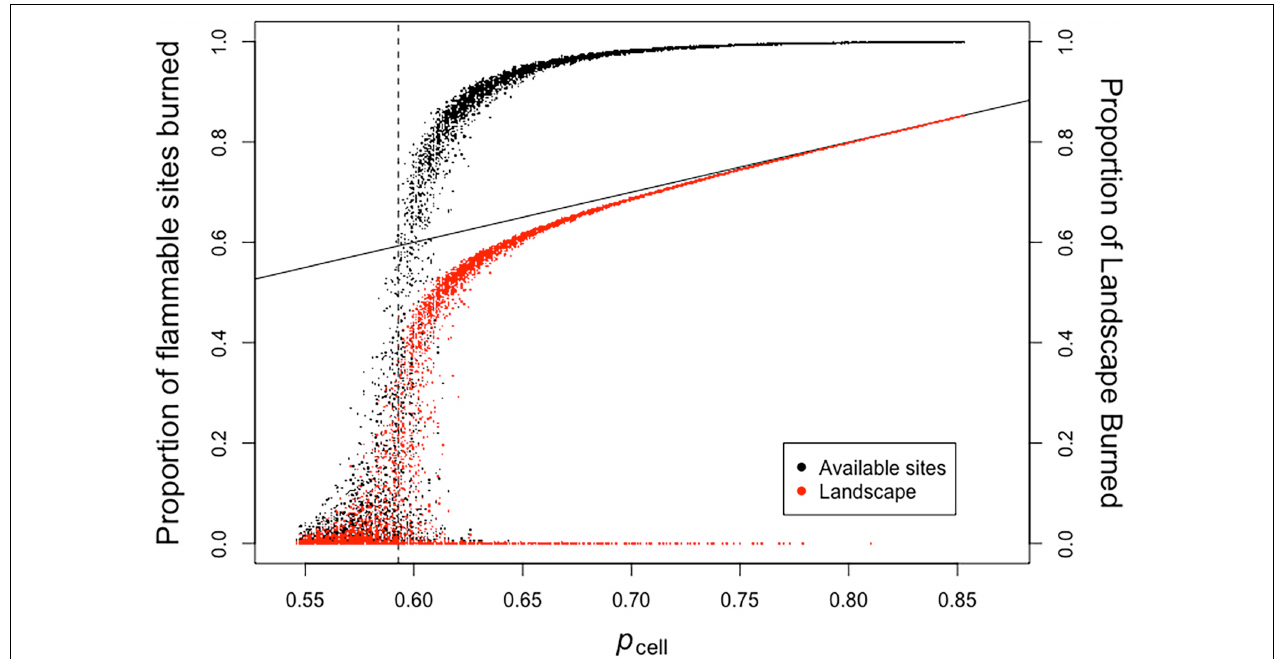
FIGURE 7 | Point source ignition experiments for a binary landscape. The probability of a cell being flammable ( p cell ) was varied from 0.55 to 0.85 in increments of 0.002 for each burn experiment with 100 replicates for each value of p cell . Proportion of available sites burned is the number of cells burned divided by the number of flammable cells in each model run. Proportion of landscape burned is the number of burned cells divided by the total number of model cells in each model run. The vertical dashed line is p crit . The solid sloped line is y = x .